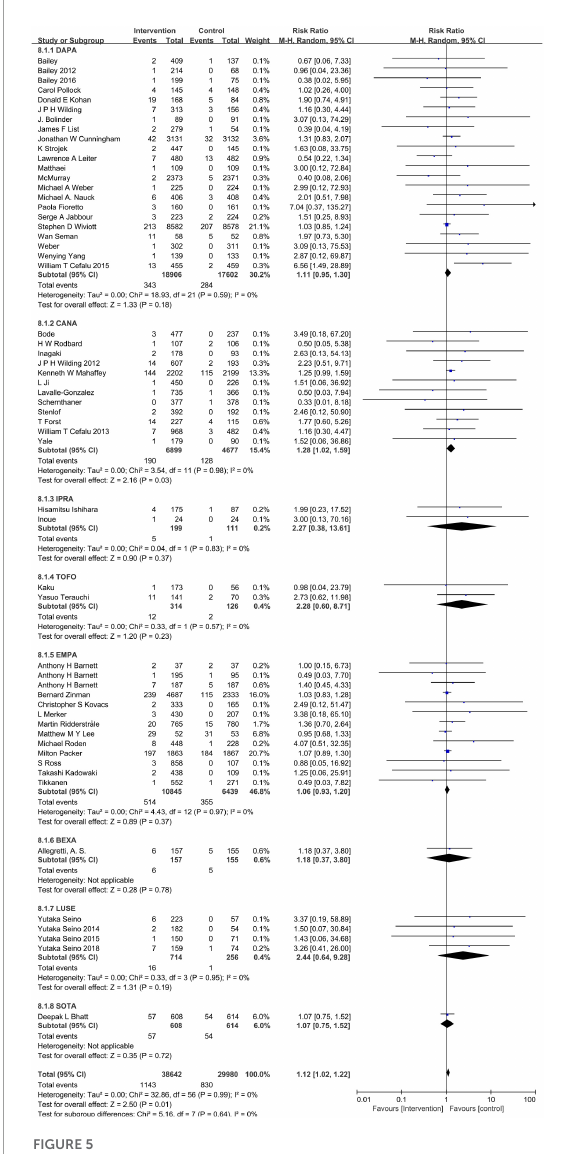
FIGURE5 Subgroup analysis of the hypovolemia events between the SGLT2 inhibitors group vs. placebo group stratified by category of SGLT2 inhibitors. DAPA, dapagliflozin; CANA, canagliflozin; IPRA, ipragliflozin; TOFO, Tofogliflozin; EMPA, empagliflozin; BEXA, bexagliflozin; LUSE, luseogliflozin; SOTA,